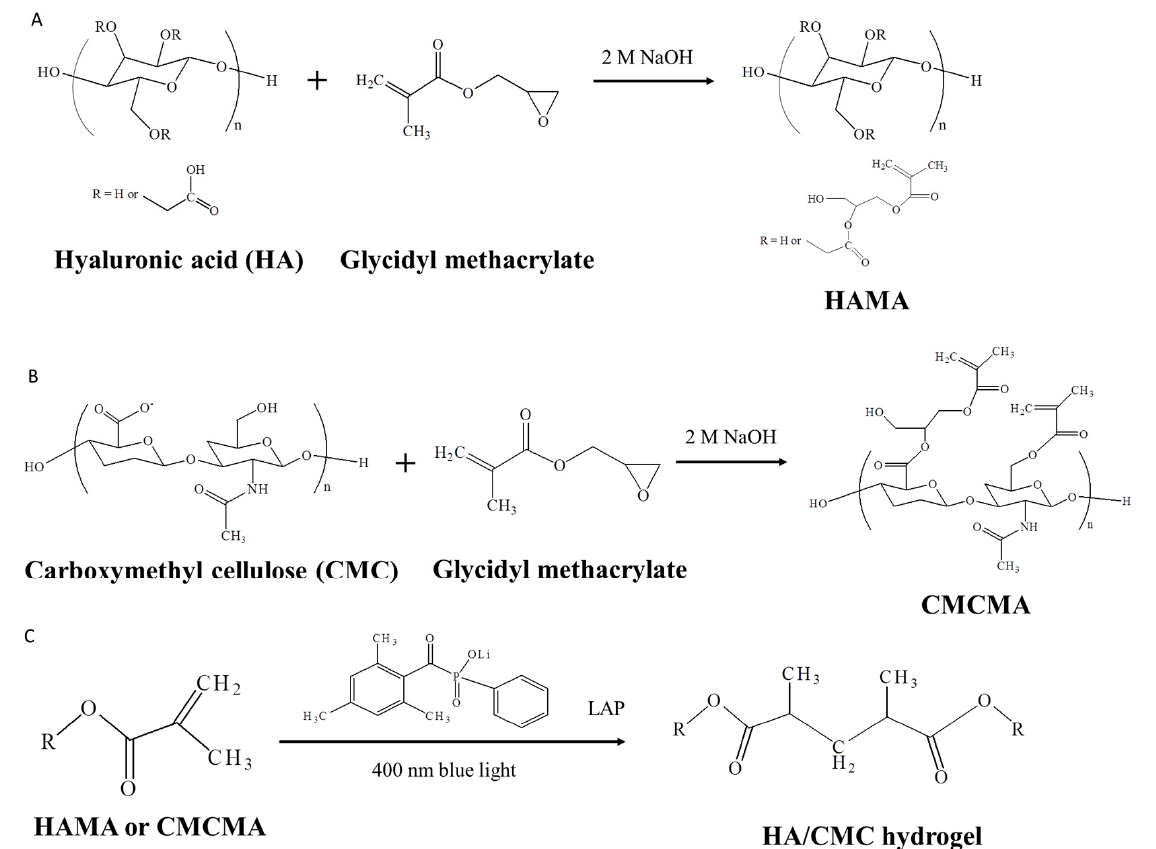
Figure 1. The synthesis of hyaluronic acid methacrylate (HAMA) ( A ), carboxymethyl cellulose methacrylate (CMCMA) ( B ) by reacting hyaluronic acid (HA) and carboxymethyl cellulose (CMC) with glycidyl methacrylate. ( C ) The synthesis of HA/CMC hydrogel by photo-crosslinking reactions. The rheological analysis demonstrates that the storage modulus (G (cid:48) ) of HC13 hydrogel is much higher than that of the HAMA/CMCMA polymer solution (1/3 mass ratio), albeit the increase of loss modulus (G”) is less (Figure 2A). This results in a drastic reduction of the loss tangent (tan δ = G”/G (cid:48) ) of the polymer solution (~14) to the hydrogel (~1) after photo-crosslinking (Figure 2B). Taken together, these results indicate HA/CMC hydrogel could be synthesized from HAMA/CMCMA with blue light exposure for 3 min to induce sol-to-gel phase transition.